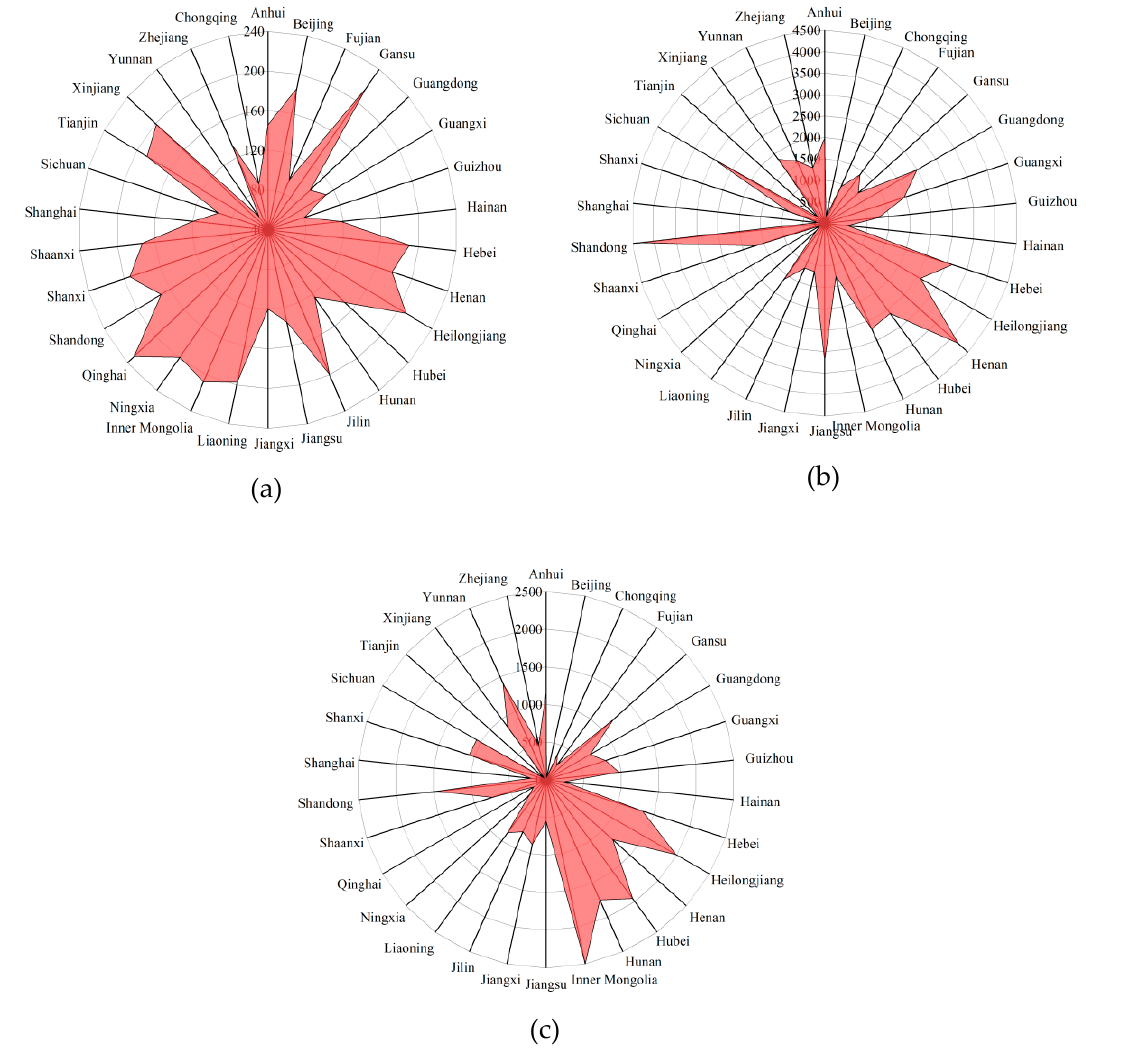
Figure 5. Radar maps of the following variables for each province over 8 years (China). ( a ) Extreme weather days (EWD); ( b ) gross output value of agriculture (GOVA); ( c ) crop disaster area (CDA).